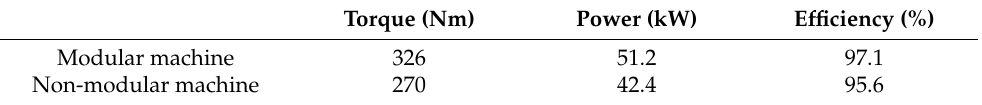
Table 4. EM performance with coupled models for the modular and non-modular SPM